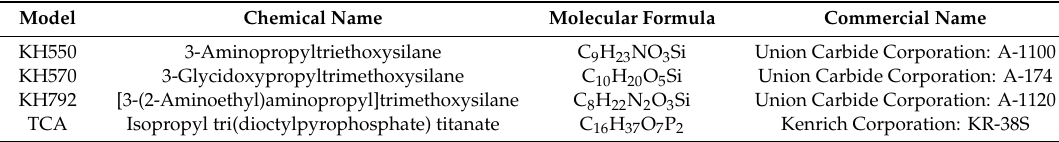
Table 4. The basic information of the four coupling